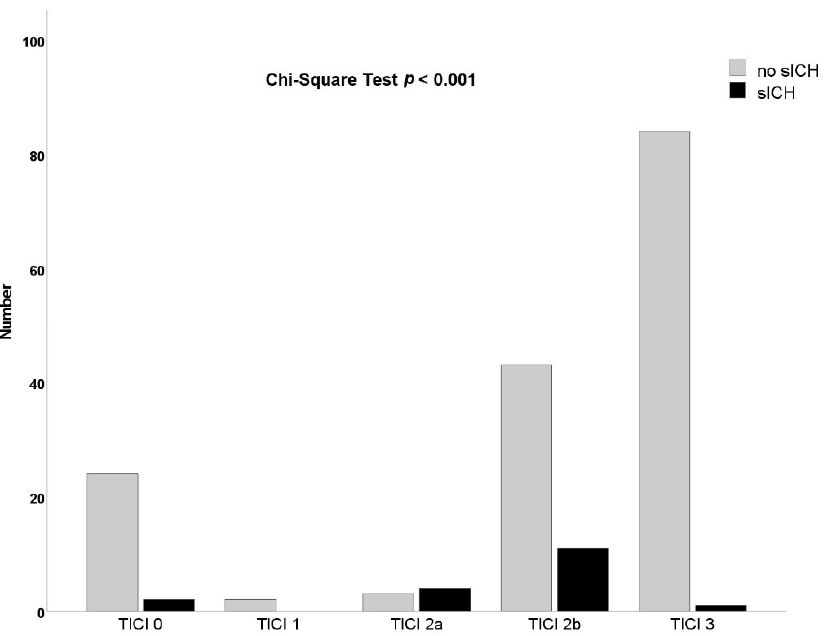
Figure 2. Reperfusion grade and presence of symptomatic intracranial hemorrhage. TICI = throm- bolysis in cerebral infarction scale; sICH = symptomatic intracranial hemorrhage.